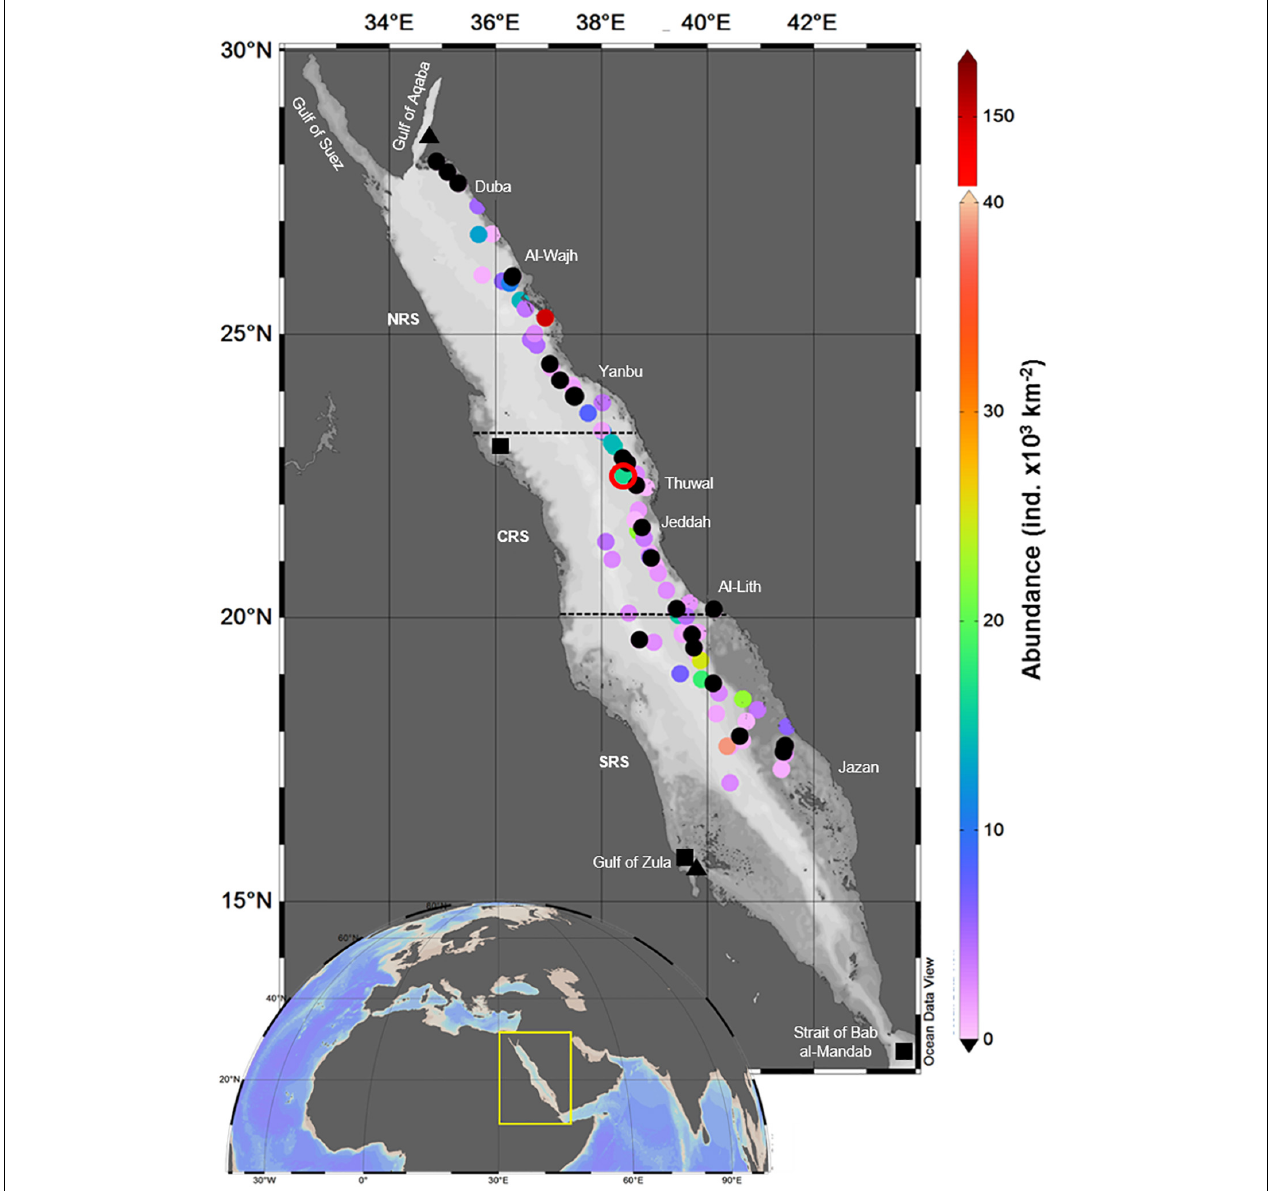
FIGURE 1 | Sampling locations (colored dots, time series station outlined in red) and corresponding abundance of Halobates germanus (individuals × 10 3 km − 2 ) in the Red Sea during 2016–2018. The regions of the northern Red Sea (NRS), the central Red Sea (CRS), and the Southern Red Sea (SRS) are delineated with black dash lines. Abundance values are represented according to the color palette on the right. Note the difference in the scale bar. Black dots correspond to locations with negative tows (absence of H. germanus in the samples). Abundance at the time series station is the average of 38 samples. Previously reported occurrence of other two species, H. melleus (black triangle) and H. hayanus (black square) is also